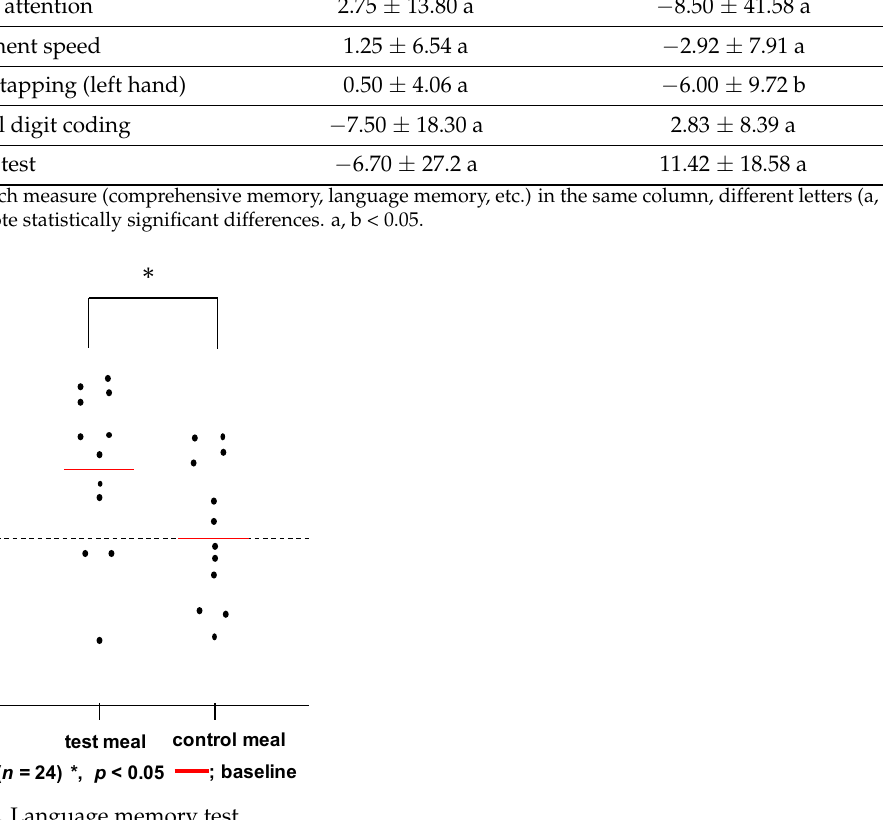
Figure 2. Language memory test.